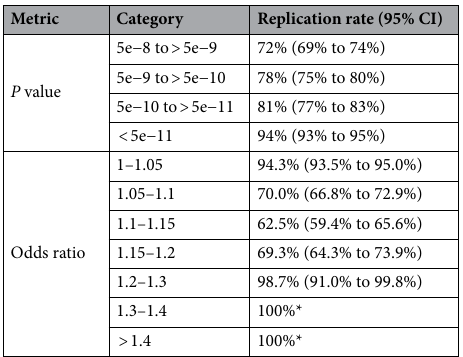
Table 2. Replication across P values and odds ratios. *Paucity of data prevented formal meta-analysis.